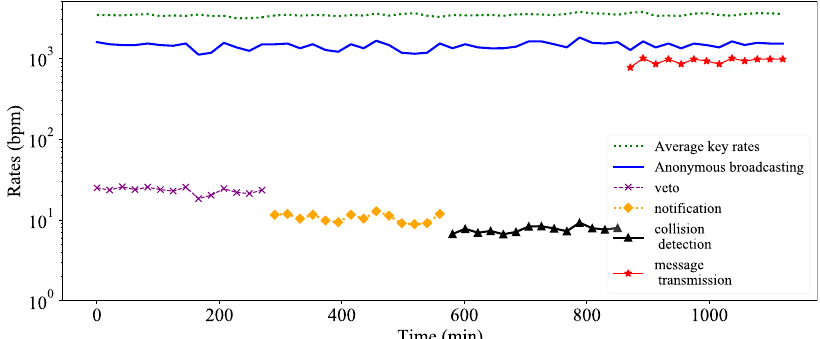
Fig. 5 Anonymous communication rates over time for the lab experiment. We show: the data the average key generation rate across all the links (green dotted line), anonymous broadcasting (parity) (blue solid line) and rate at which veto (purple crosses), noti fi cation (yellow diamonds), collision detection (black triangles) and message transmission (red stars) were performed. To ensure a minimum success probability of >99.99% (1 for veto) we used β = 16. Here the keys are generated every 20 min while including fi nite key